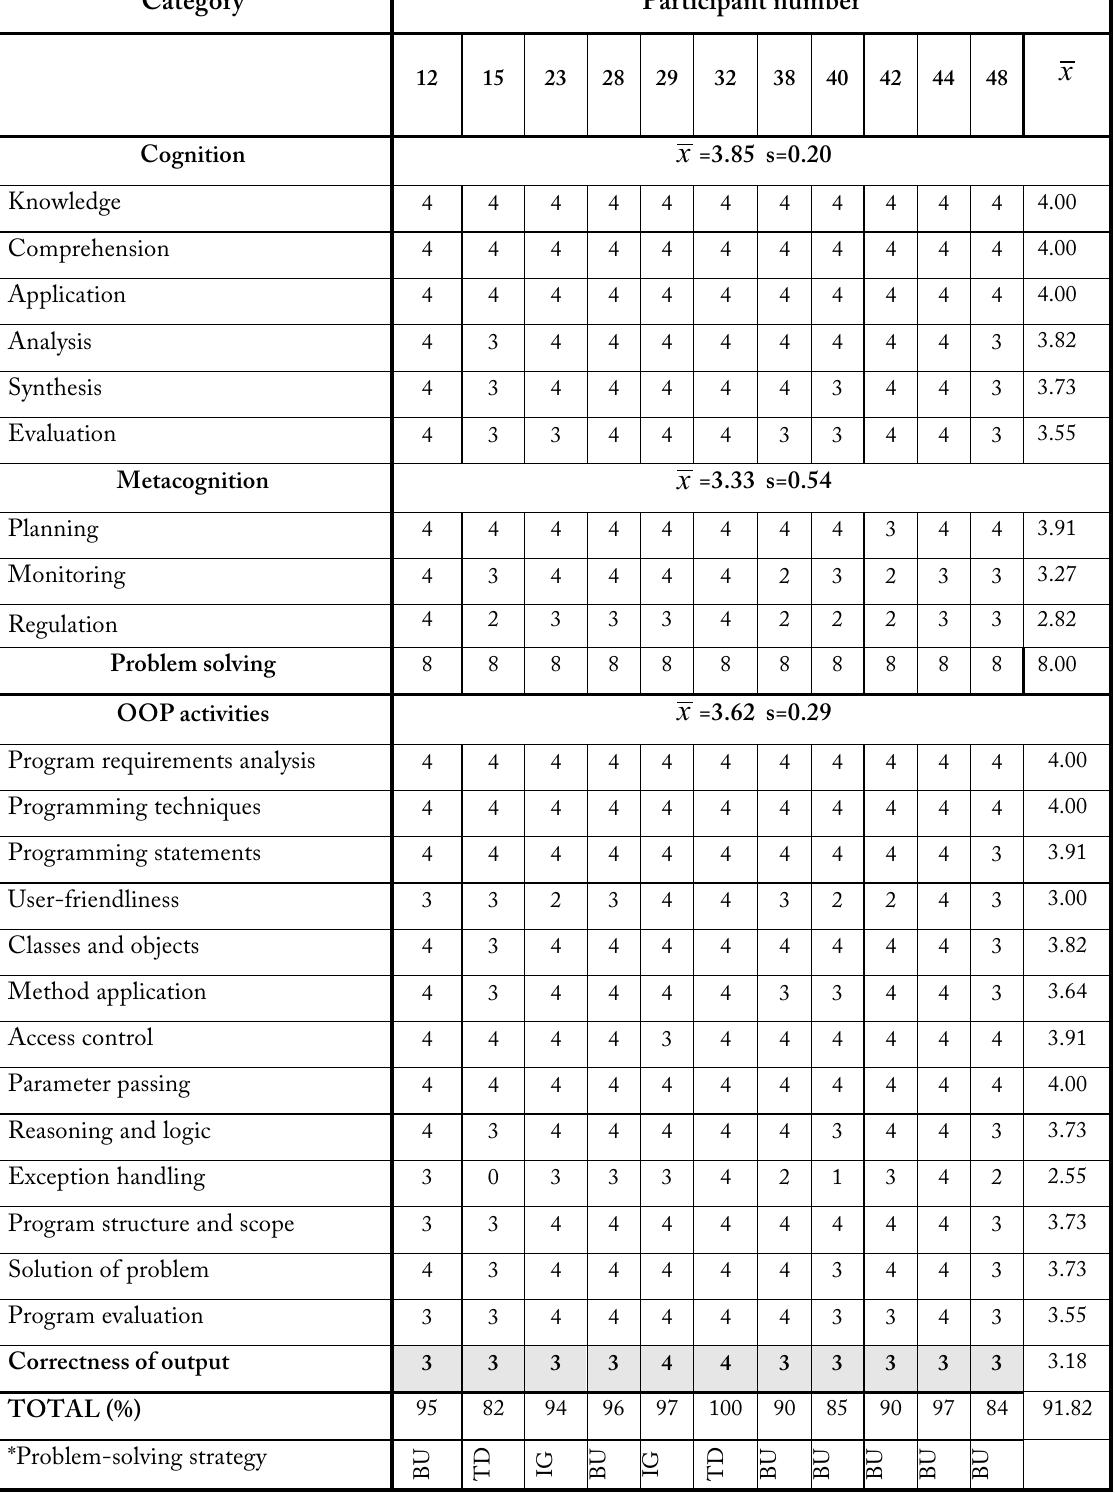
Table 2: Means and standard deviations of successful programmers’ results